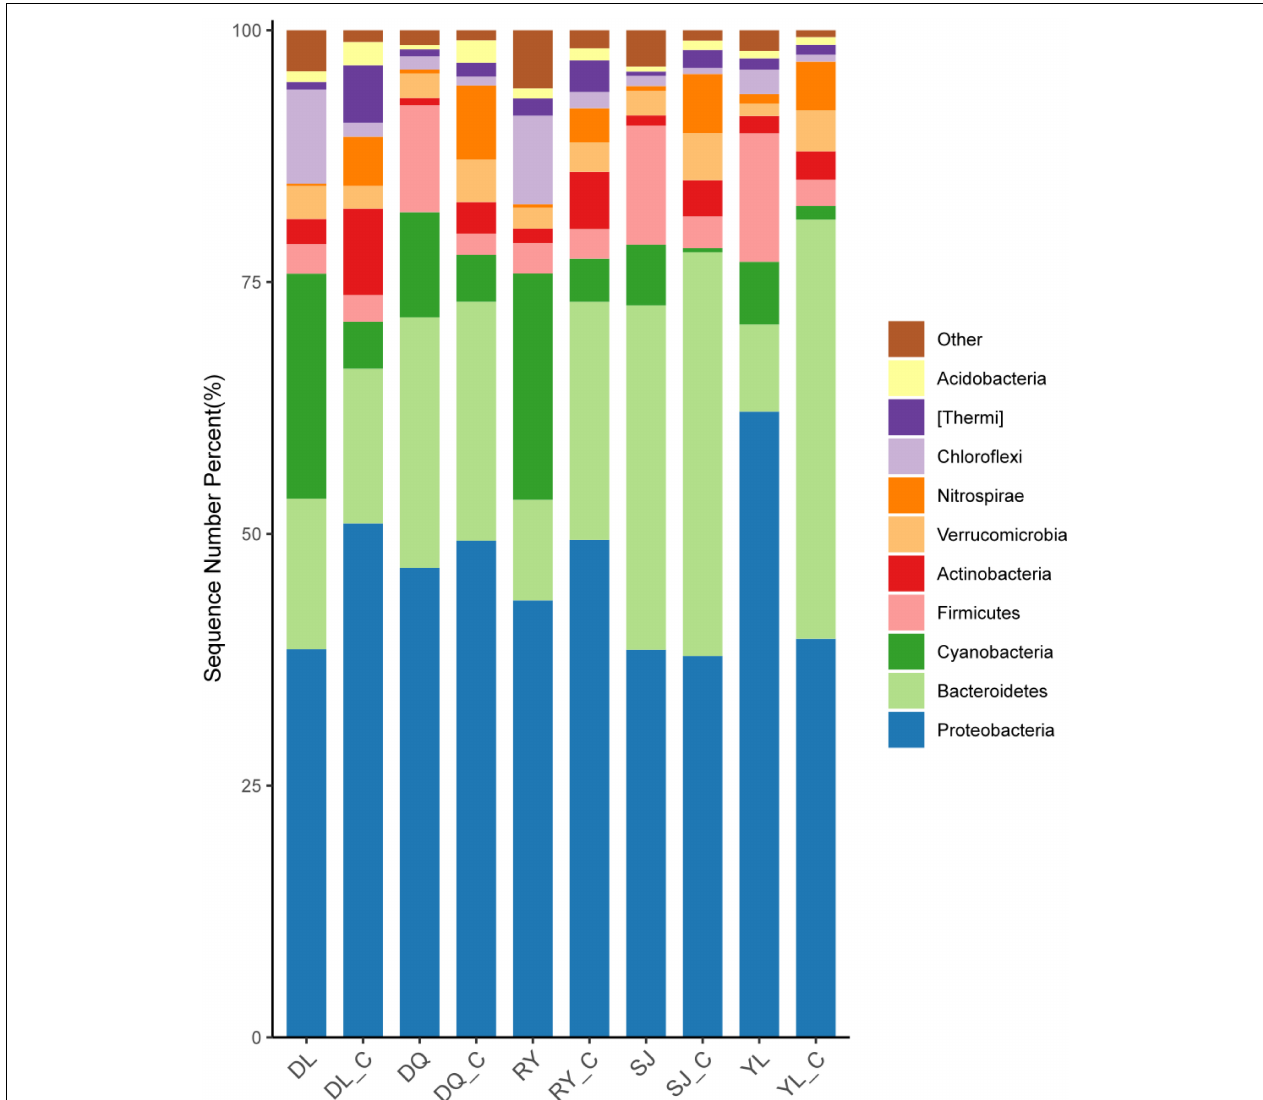
FIGURE 4 | Changes of in situ microbial populations of bio-eroded shells in different aquatic environment. DL, DQ, RY, SJ, and YL represent the microbial communities of bio-eroded shells from five different geographical locations, respectively. DL_C, DQ_C, RY_C, SJ_C, and YL_C represent the microbial communities of the healthy snail shells from five different geographical locations, respectively. SL, Sanjiang County; YL, Yongle Town; DL, Dongliang Village; DQ, Dongquan Town; RY, Renyi Village.